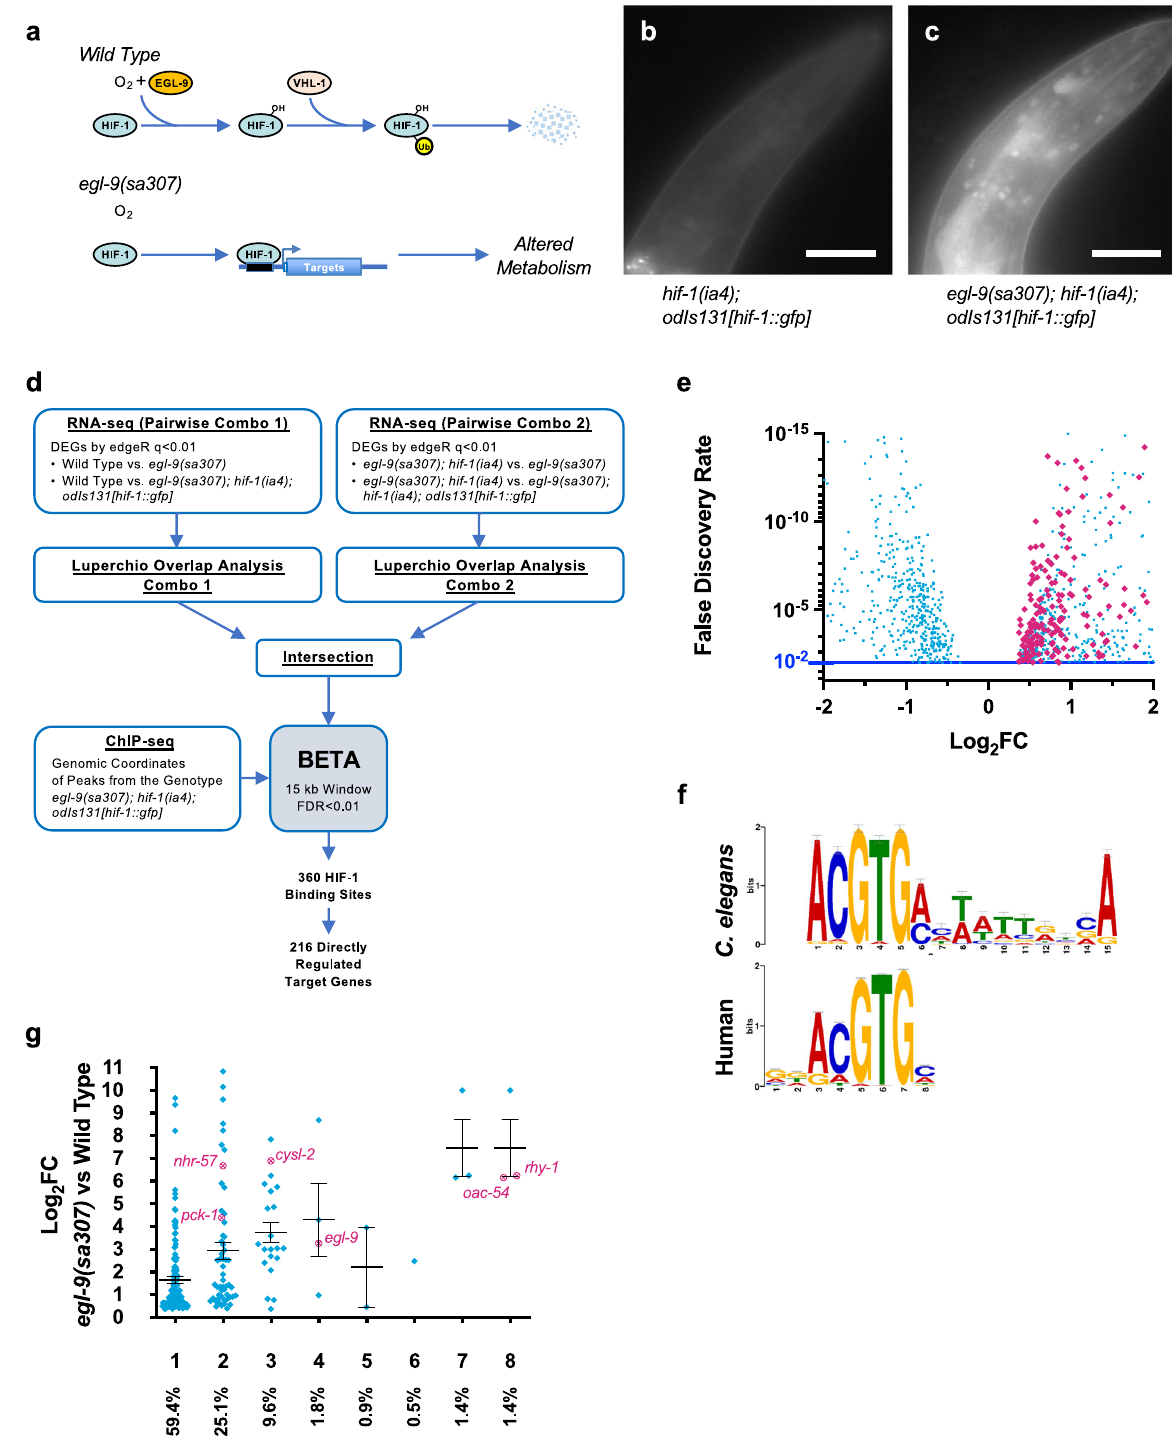
Fig. 1 | Identifying genes directly regulated by HIF-1. a Diagram of the hypoxia response pathway in C. elegans . HIF-1 is hydroxylated by EGL-9, ubiquitinated by VHL-1, and degraded by the proteasome. In egl-9(sa307) mutants, HIF-1 remains stable and regulates the transcription of target genes whose expression alters metabolism. b , c HIF-1::GFP fl uorescence in the indicated genotypes under nor- moxia. Scale bar indicates 30 microns. Similar results were obtained in three independent trials. d Strategy for integrating HIF-1 ChIP-seq and RNA-seq data to identifydirectlyregulatedtargets. e VolcanoplotofRNA-seqFDRvaluesversuslog 2